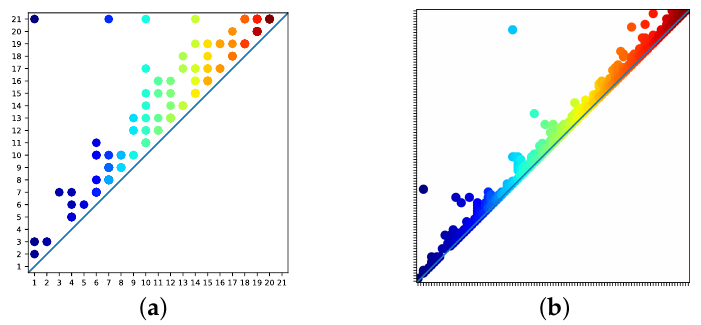
Figure 9. The persistence diagrams corresponding to the tracking of Figures 8 and 10 are displayed in ( a ), ( b ), respectively. The total number of points in these diagrams are 158 and 856, respectively; many of these points have the same coordinates.